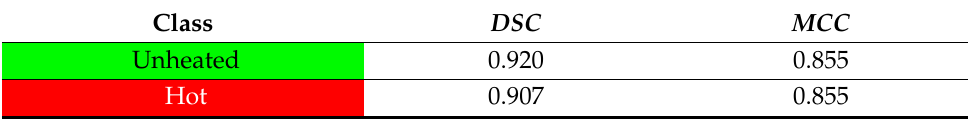
Table 2. DL-MWI Spinal cord CNN performance